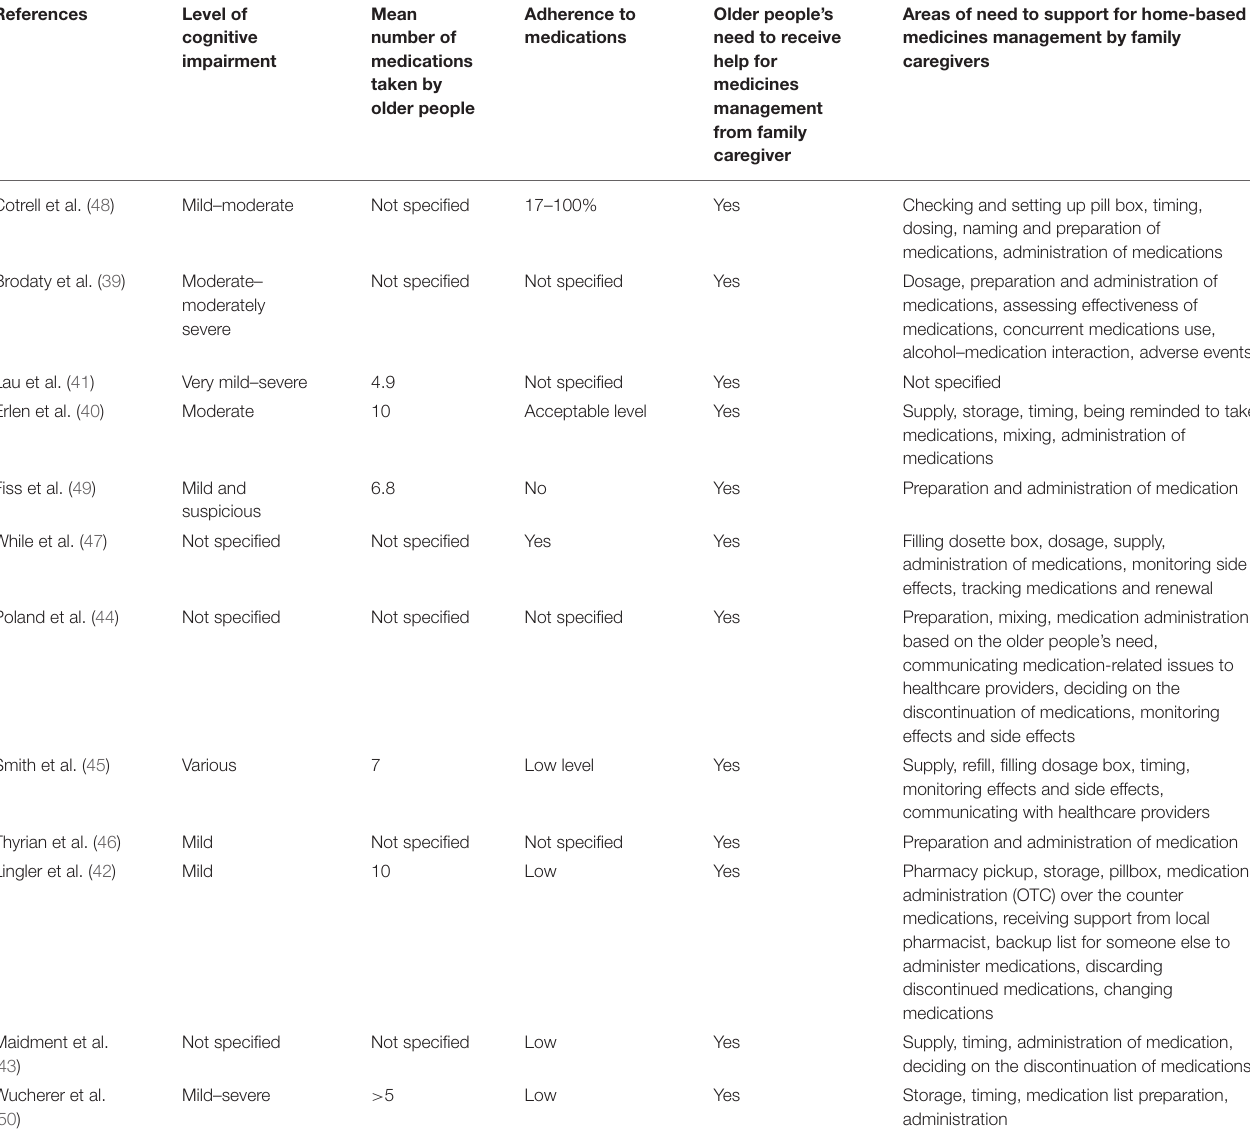
TABLE 3 | Medicines management and the need of older people with cognitive disorders to receive support in their own